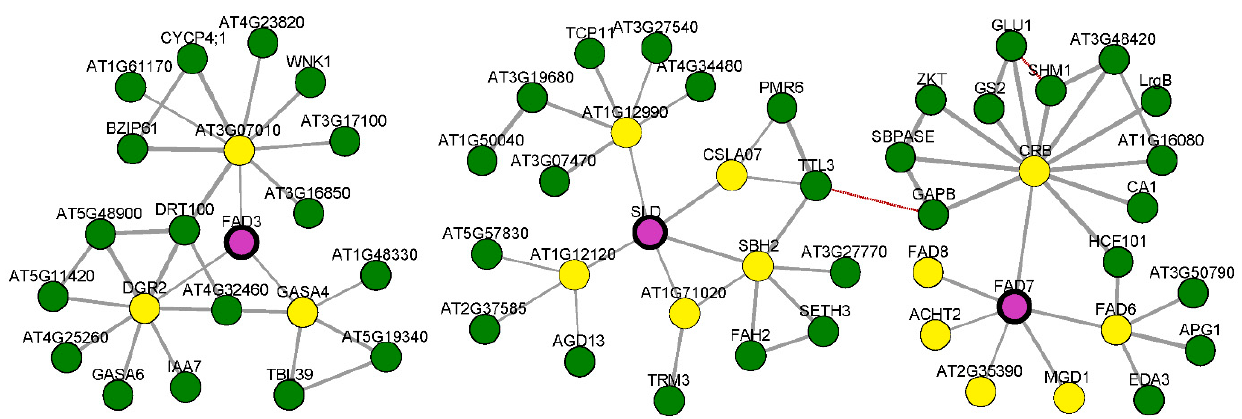
Figure 7. Co-expression of homologous genes of putative drought-related Ah|FADs in Arabidopsis thaliana.